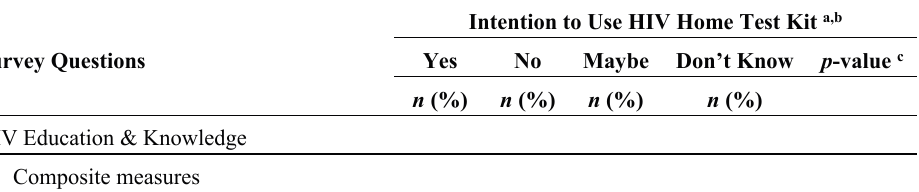
Table 2. HIV Knowledge, attitudes, and beliefs by Intention to use a HIV home-test kit among Latino farmworkers, North